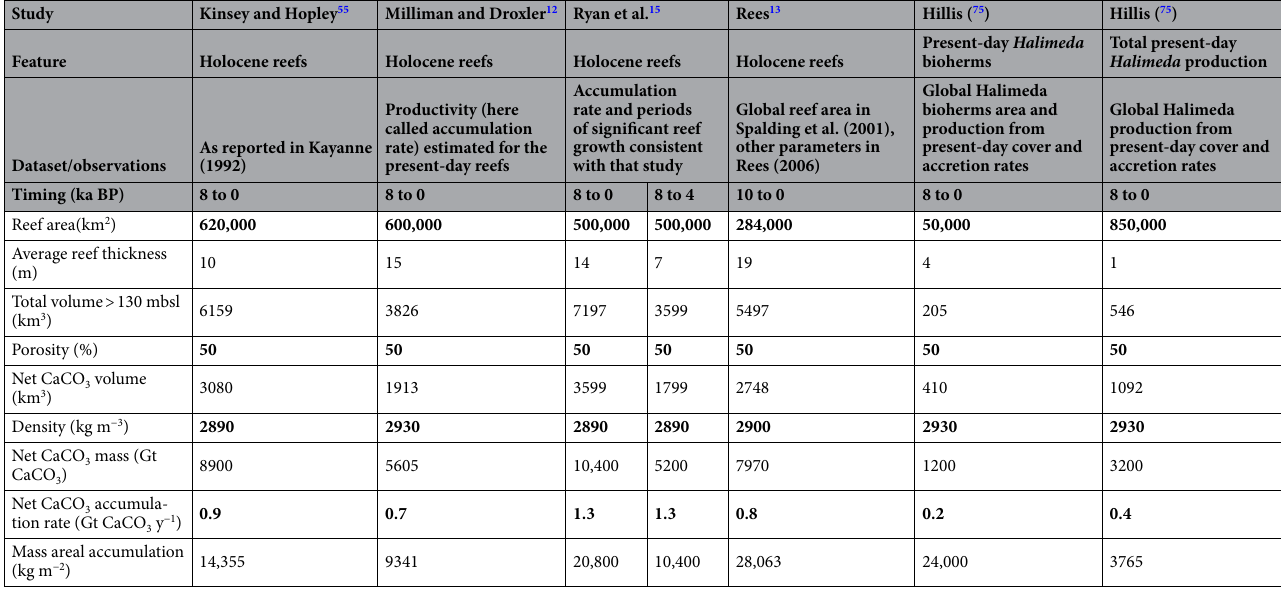
Table 6. Global estimates of CaCO 3 mass and/or accumulation rate of present-day shallow-water reefs, Holocene reefs and Halimeda bioherms according to different authors. To establish a comparison among new and past estimates, some of the values were calculated using the parameters highlighted in